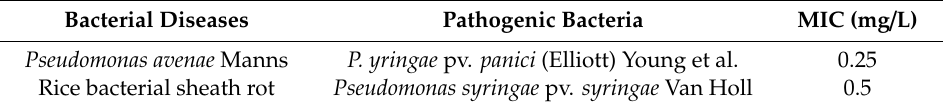
Table 2. MIC of CMC-SNs against P. syringae pv. panici (Elliot) Young et al. and Pseudomonas syringae pv. syringae Van